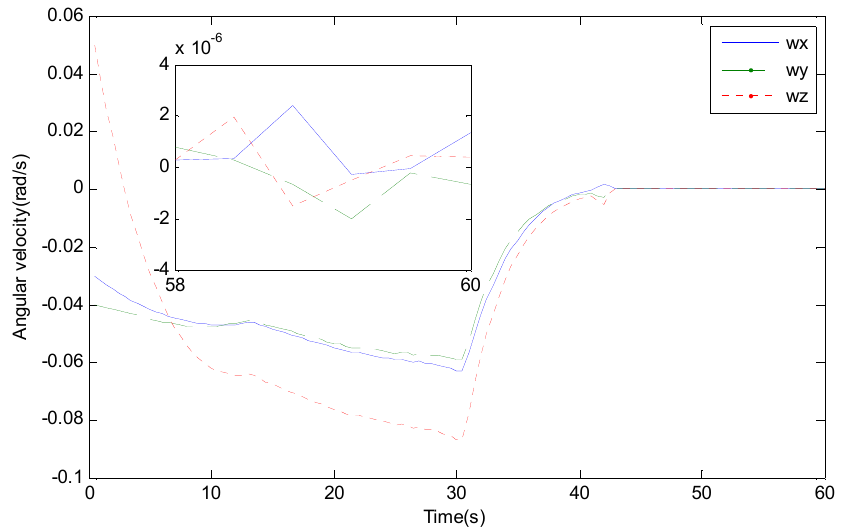
Figure 9. Curve of angular velocity.